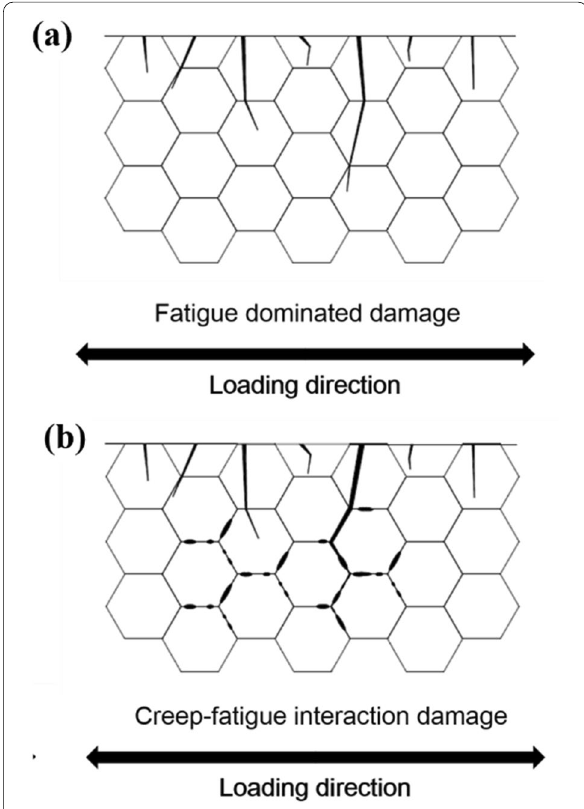
Figure 9 The schematic diagram of two creep-fatigue fracture mechanisms of CF-tested P92 steel welded joint under prior creep-fatigue damages with short dwells (30 and 120 s) or long dwells (600 and 900 s)